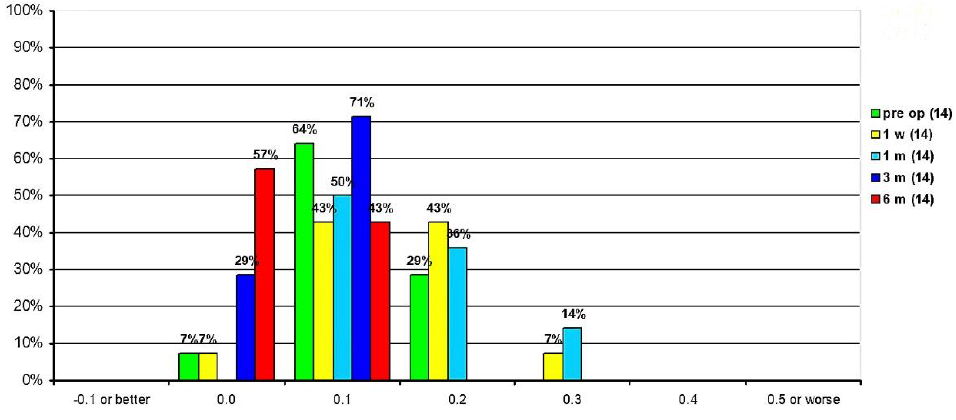
Figure 4. Uncorrected distance visual acuity percentage